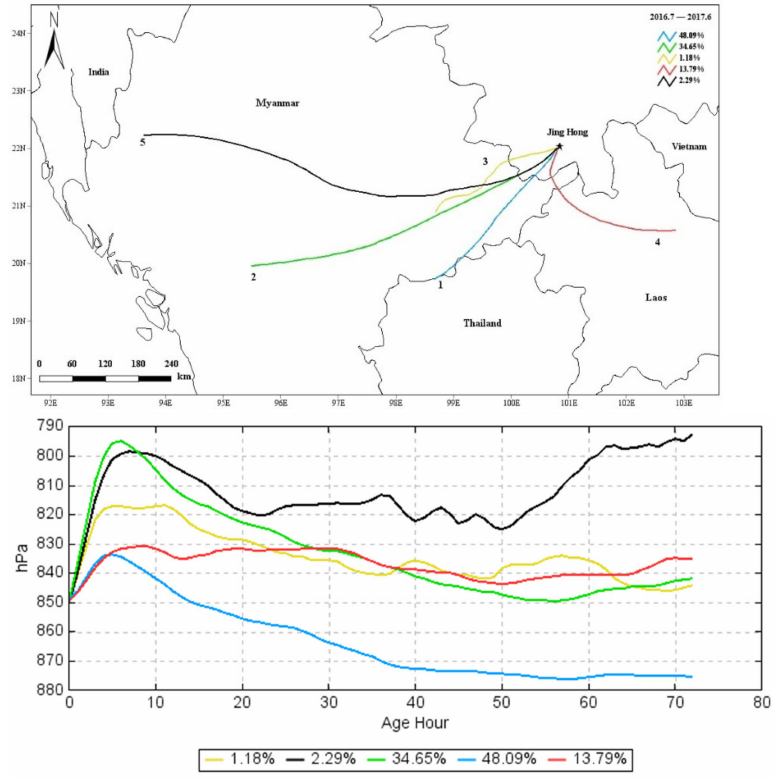
Figure 4. Trajectory clustering from July 2016 to June 2017. Table 5. Statistical results of various trajectory pollutant concentrations from July 2016 to June 2017 in